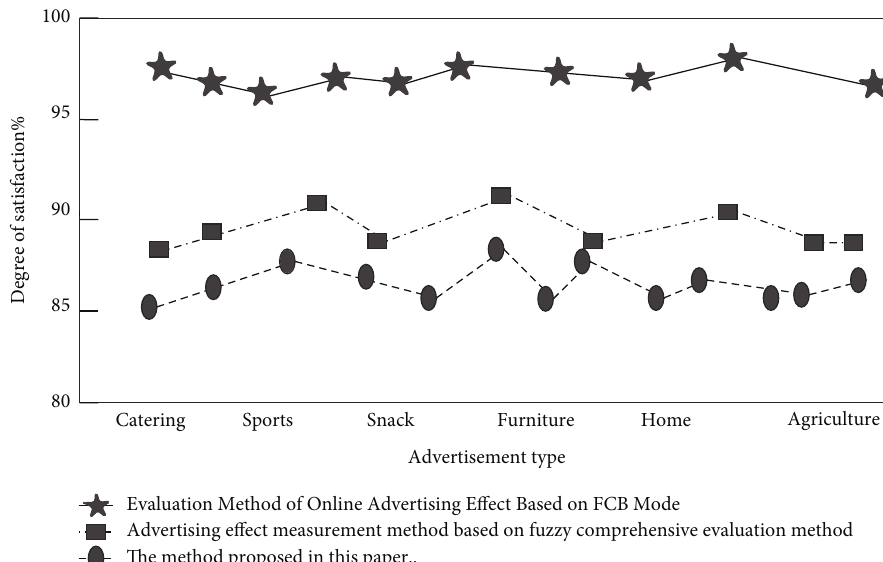
Figure 9: Test of the application effect of the method in this article.